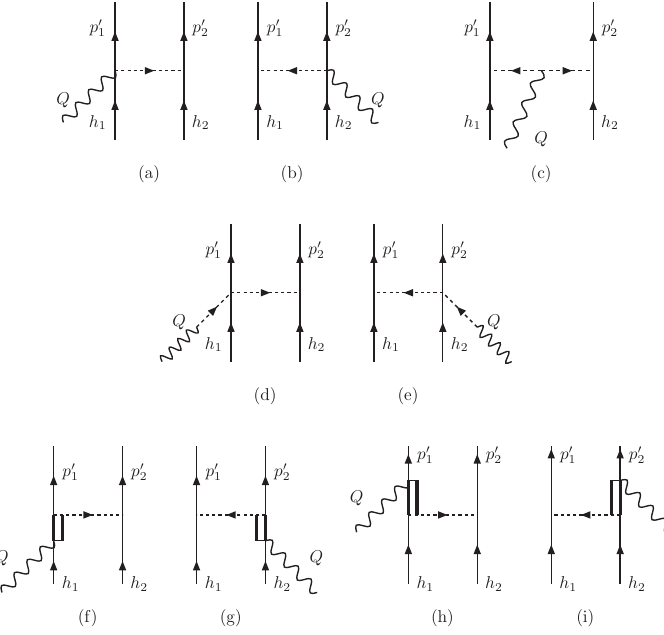
Figure 1. Weak meson exchange currents considered in this